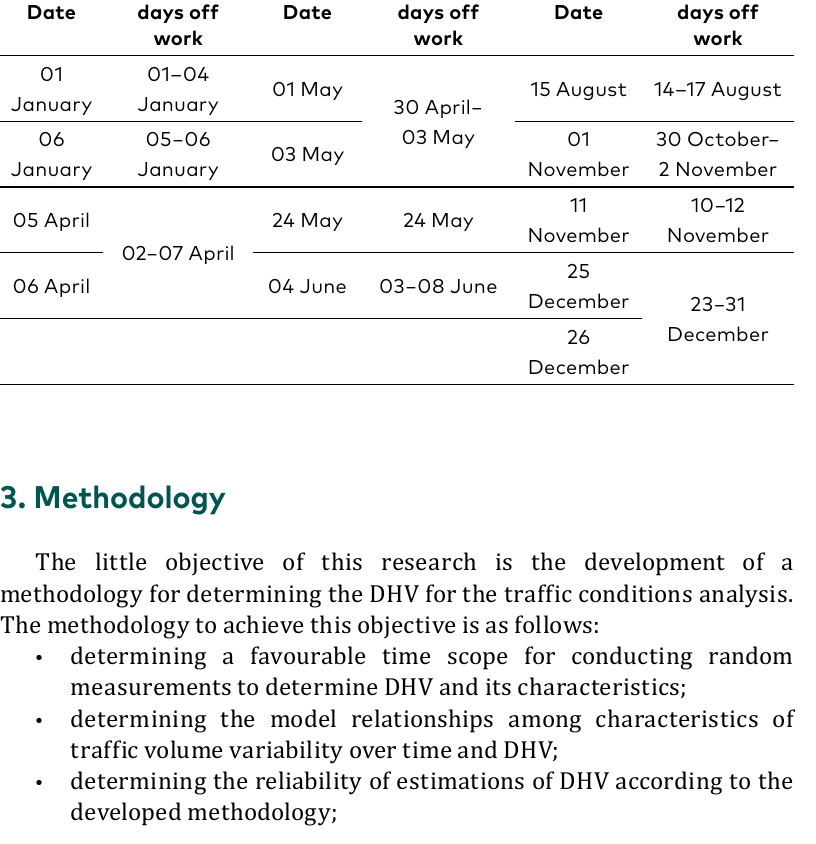
C n d n o − available number of measurement where − completeness index, %; days with correct data; − expected number of measurement days (365 or 366). Table 1. The list of public holidays and related dates in